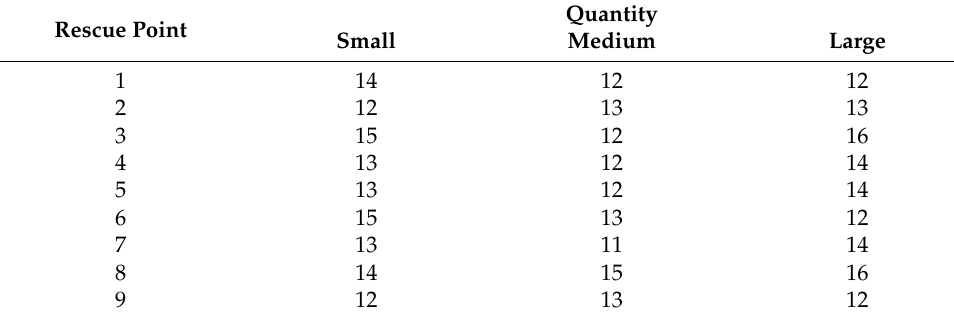
Table 6. Number of vehicles available at rescue points.